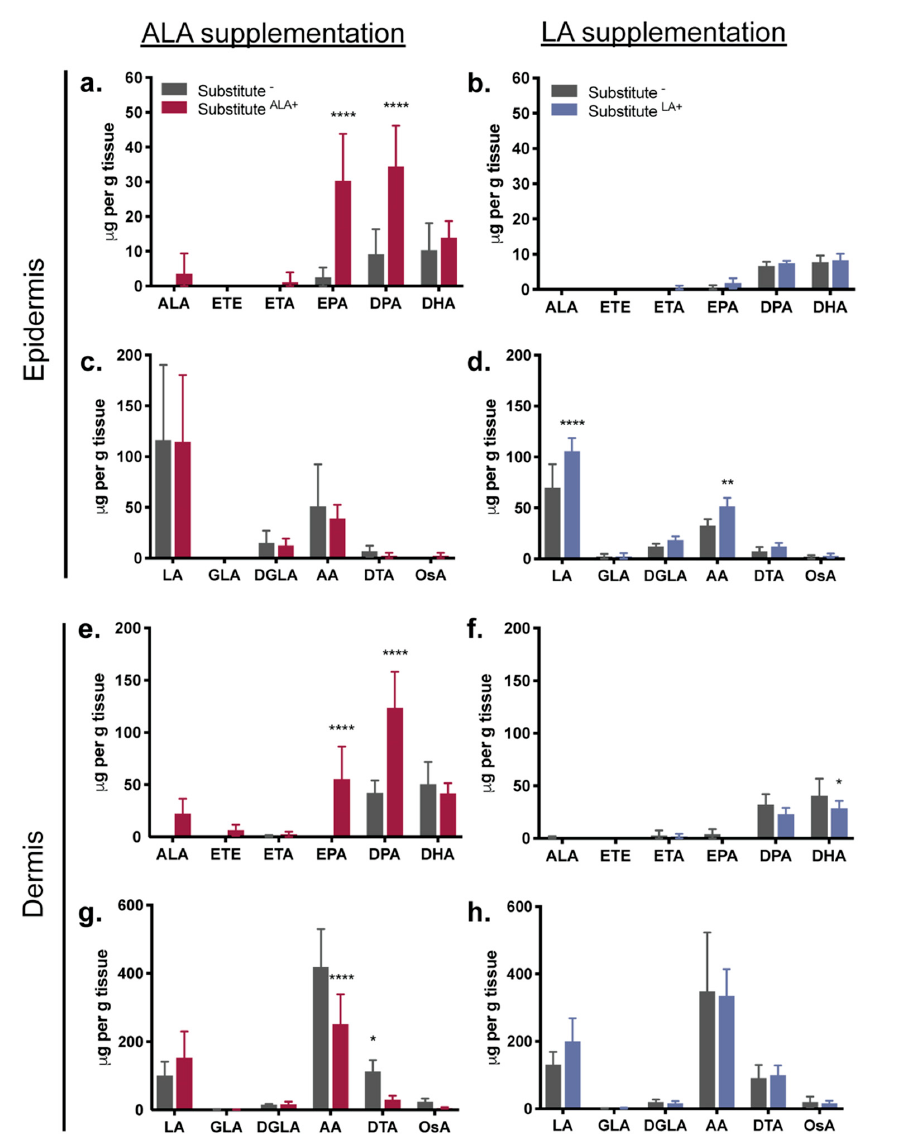
Figure 3. EFA incorporation in the epidermal and dermal phospholipid fraction of the skin substitutes. ( a , c , e , g ) ALA supplementation impact on ( a , e ) n-3 PUFAs and ( c , g ) n-6 PUFAs and ( b , d , f , h ) LA supplementation impact on ( b , f ) n-3 PUFAs and ( d , h ) n-6 PUFAs. PUFAs were quantified